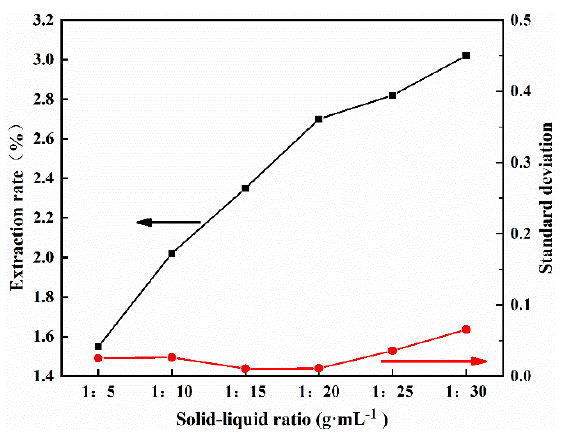
Figure 3. Effect of solid/liquid ratio on extraction rate. ( The black arrow represents the extraction rate curve and the red arrow represents the standard deviation curve. ).